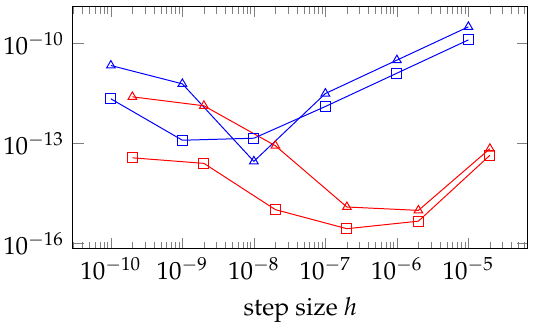
Figure 6. Accuracy of AD and DQ. Numerical error between difference quotients and AD-sensitivities of y 1 = (cid:107) u ( x , t = 4 ) (cid:107) (FDQ /CDQ ) and y 2 = (cid:107) ϕ ( x , t = 4 ) (cid:107) (FDQ /CDQ ) with regard L 2 ( Γ l ) L 2 ( Γ out ) to the period length t p = 0.6 s, evaluated at t = 4.0 s. Blue color corresponds to FDQ, red to CDQ.